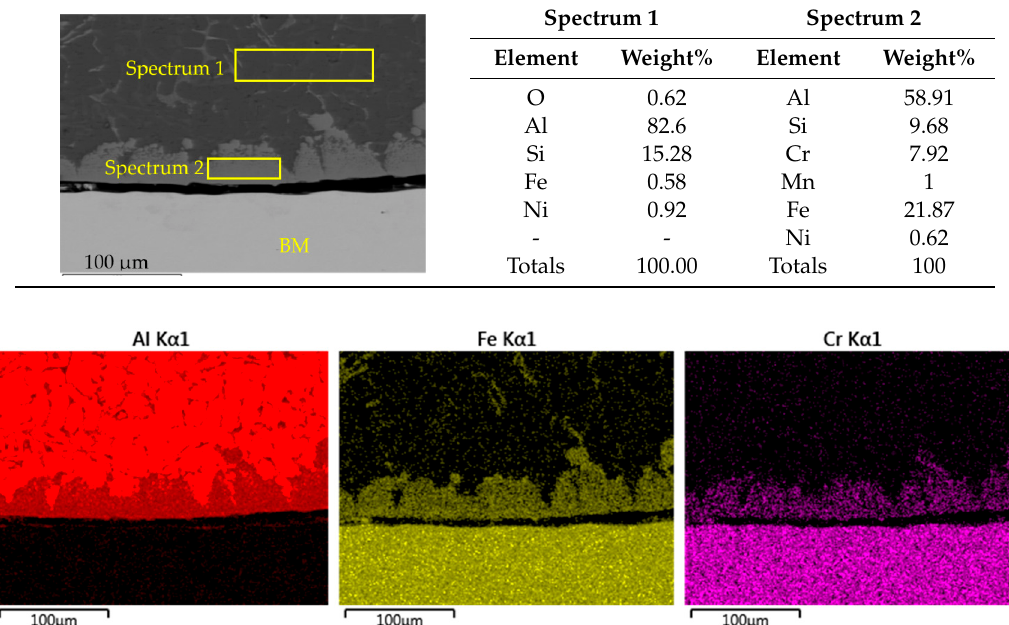
Table 11. BM/680 ± 20 °C/120 min/ENAC-AlSi9. EDX semi-quantitative microanalyses.